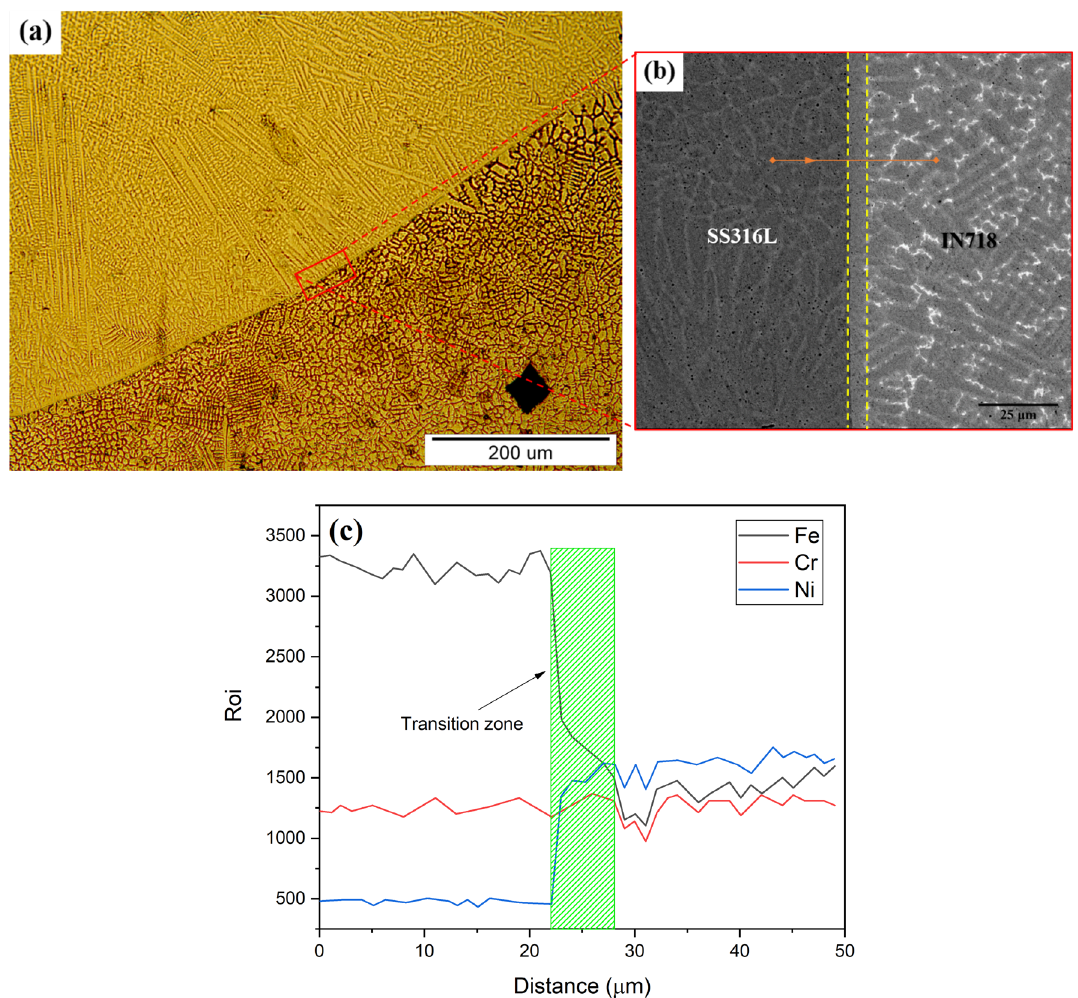
Figure 14. ( a ) Optical microstructure of the interface between layers 7 and 8. ( b ) SEM micrograph of the area specified in ( a ). The distance between the two dashed lines in ( b ) shows the range of planar solidification. ( c ) EDS line analysis along the specified path in ( b ) showing the transition zone at the